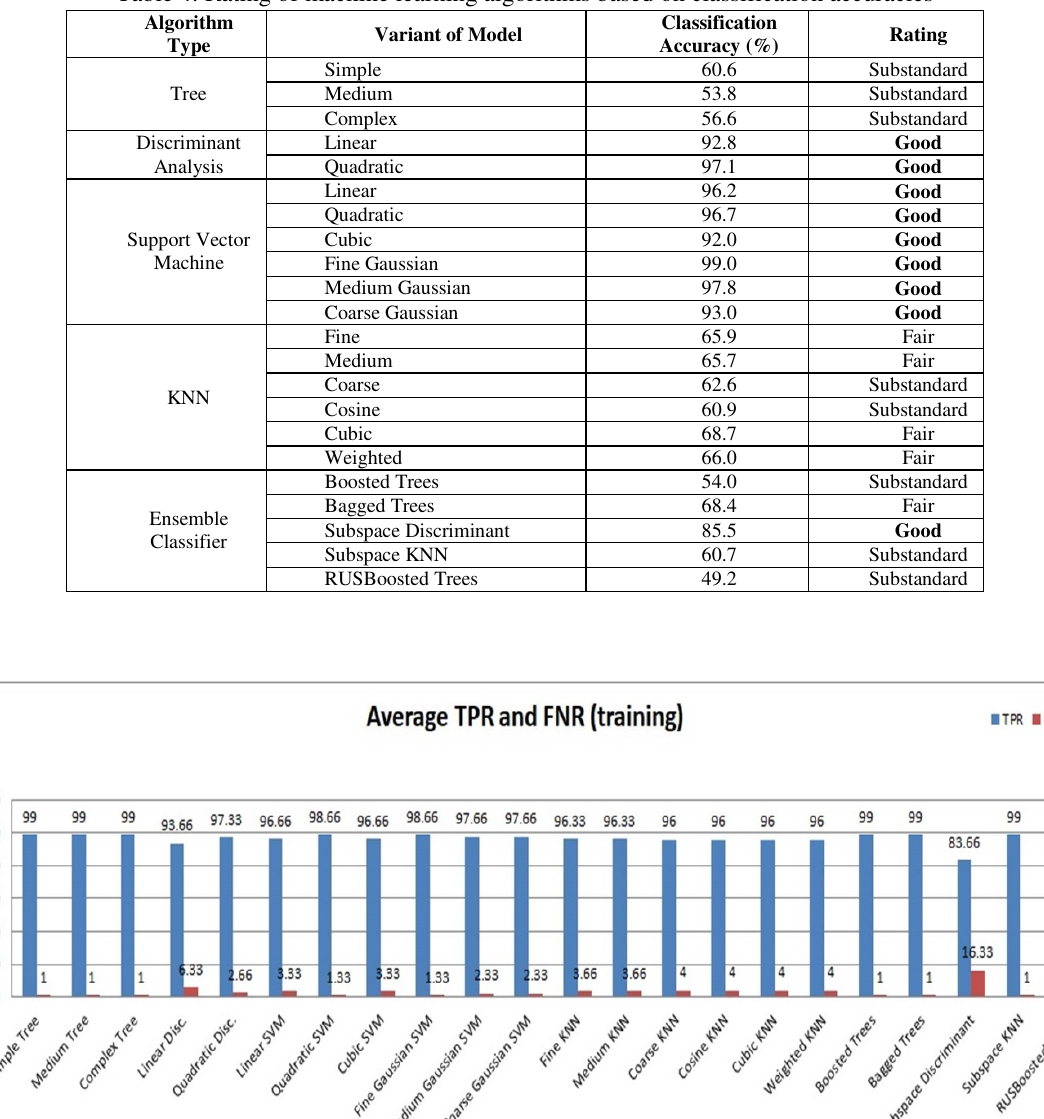
Table 4: Rating of machine learning algorithms based on classification accuracies